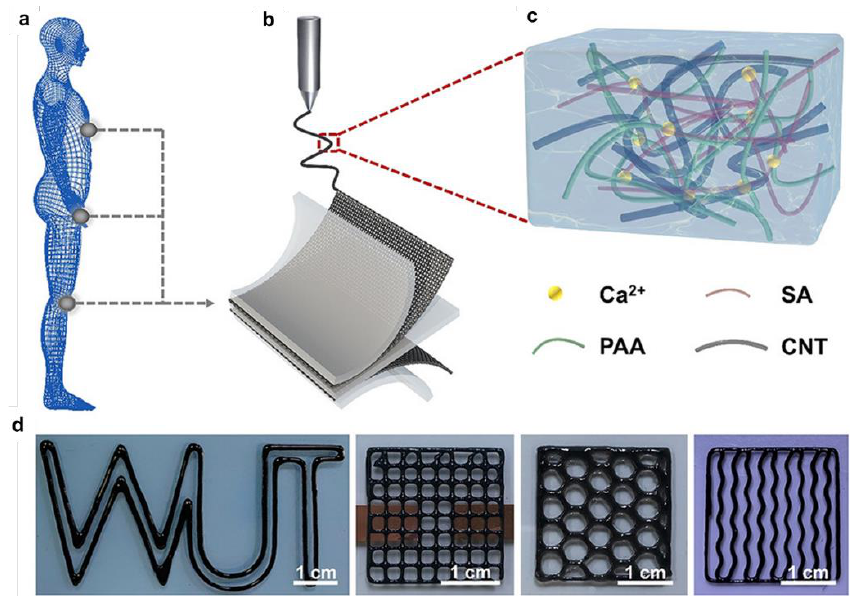
Figure 6. The process was used to prepare the Ca – PAA-= – SA – CNTs hydrogel-based strain sensor: ( a ) Detecting human body movements; ( b ) 3D printed process for preparation of the Ca-PAA-SA-CNTs hydrogels and skin-like strain sensor; ( c ) Ca-PAA-SA-CNTs hydrogels; ( d ) 3D printing of Ca-PAA-SA-CNTs hydrogels in various patterns. (reprinted with permission from ref. [84]).